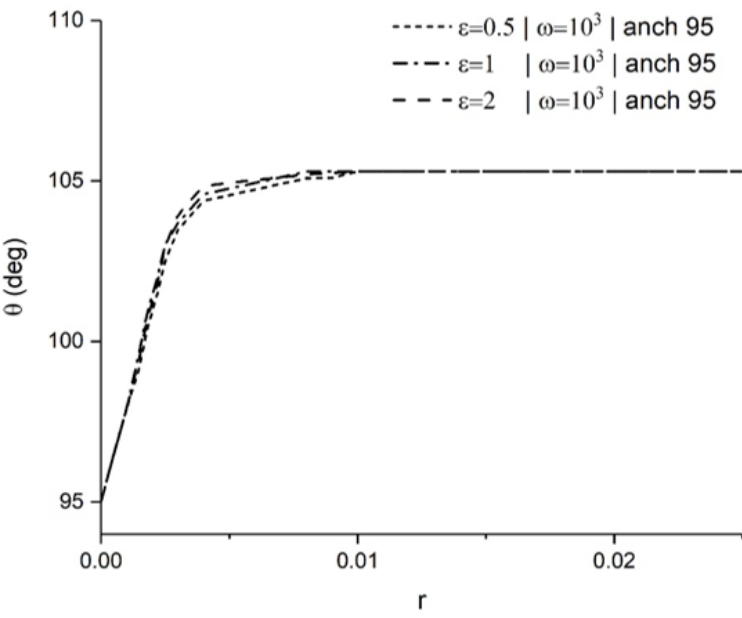
Figure 12. Variation in orientation angle for different coefficients of elasticity.